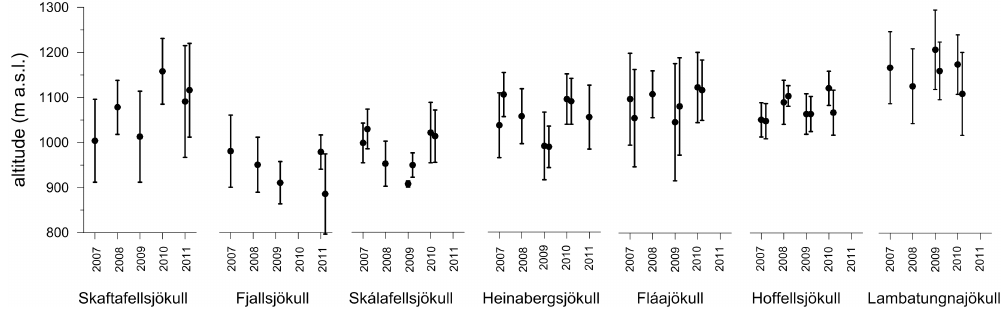
Figure 4. The elevation range (average and standard deviation) of the snowline for each glacier deduced from MODIS images (2007–2011); the elevation obtained from the lidar